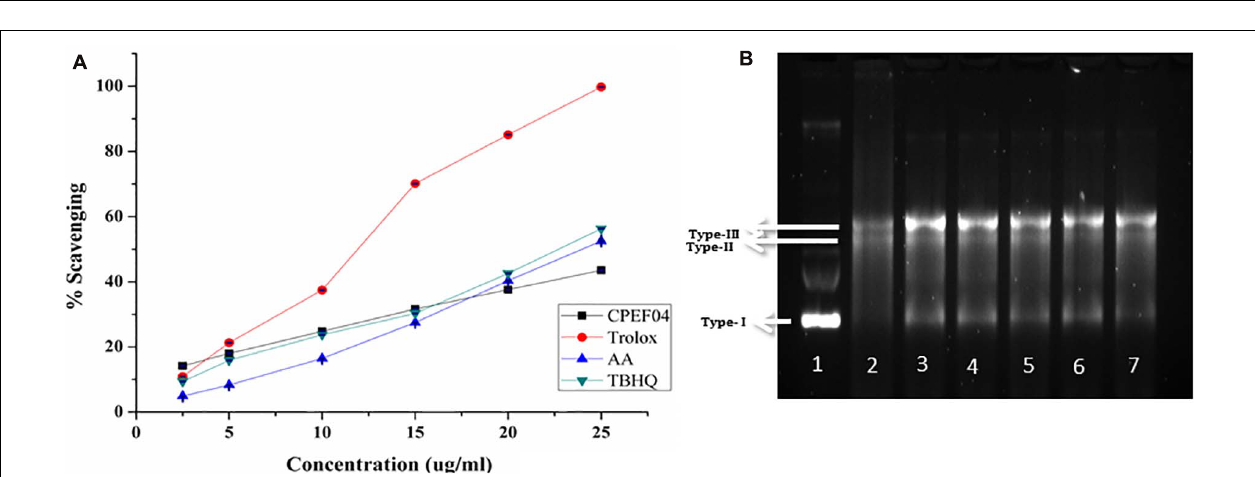
FIGURE 8 | Structure of the compounds tentatively detected on the basis of ultra-high-performance liquid chromatography–mass spectrometry.